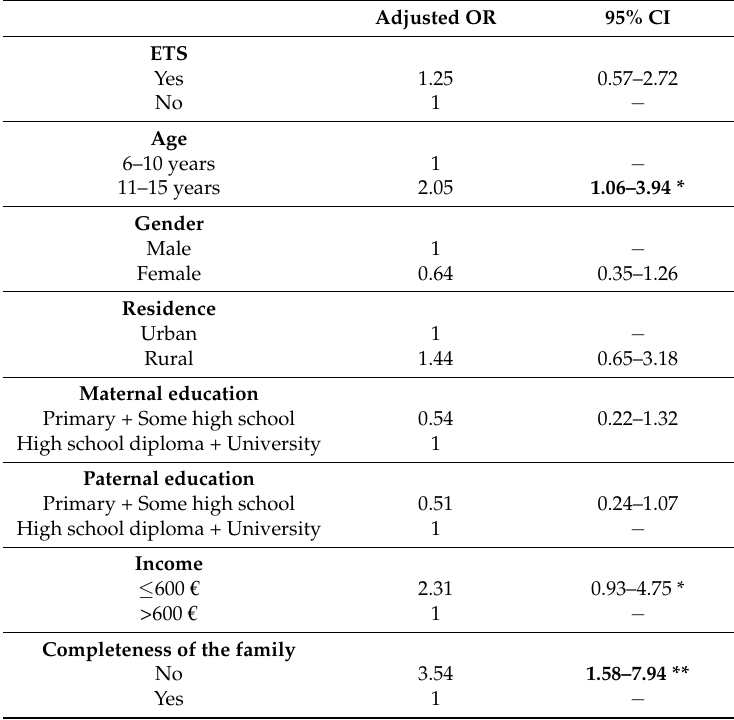
Table 7. Factors associated with Children’s Emotional Problems (CSI ≥ 16) among Children in Multivariate Analyses ( n = 1373) †